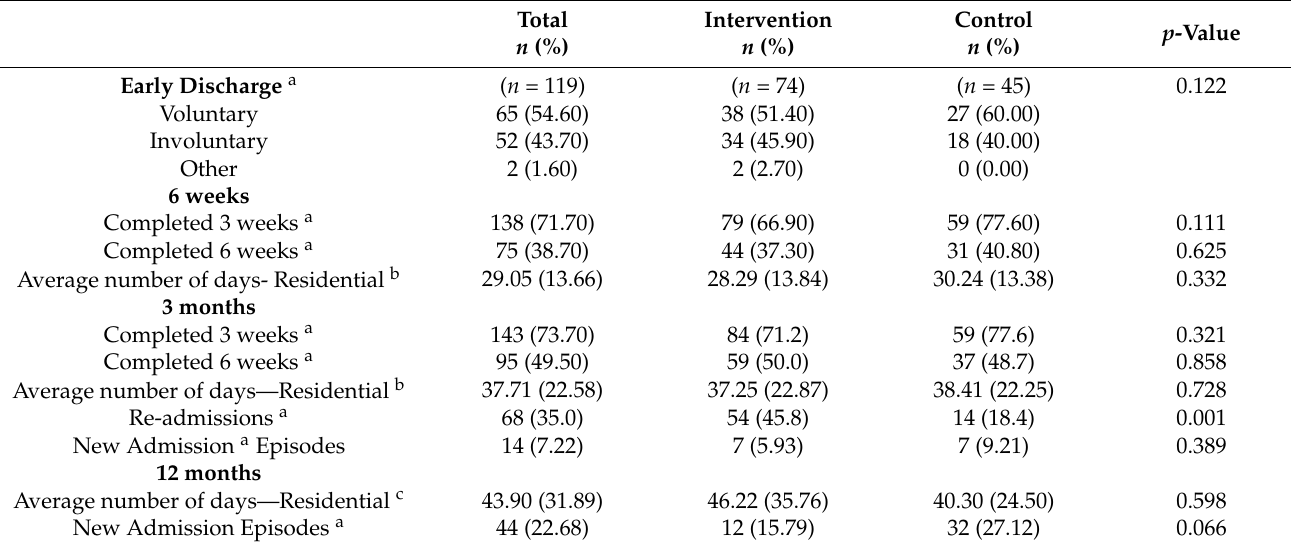
Table 2. Attendance at Residential Rehabilitation